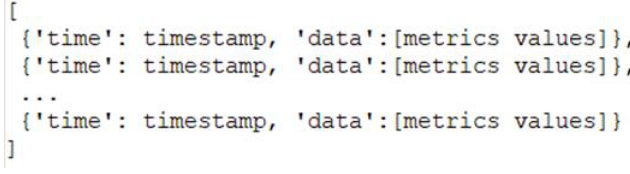
Figure 2. Raw-data